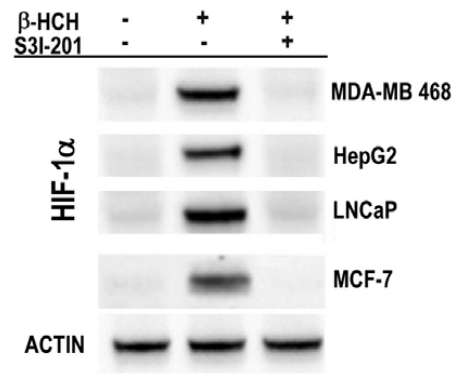
Figure 7. Immunoblot analysis of HIF-1 α expression in MDA-MB 468, HepG2, LNCaP, and MCF-7 cells after 8 h treatment with 10 µ M β -HCH. Analysis was performed after 8 h treatment with 10 µ M β -HCH, as well as on cells pre-incubated with a specific STAT3 inhibitor (S3I-201) before β -HCH treatment. Actin was used as normalization